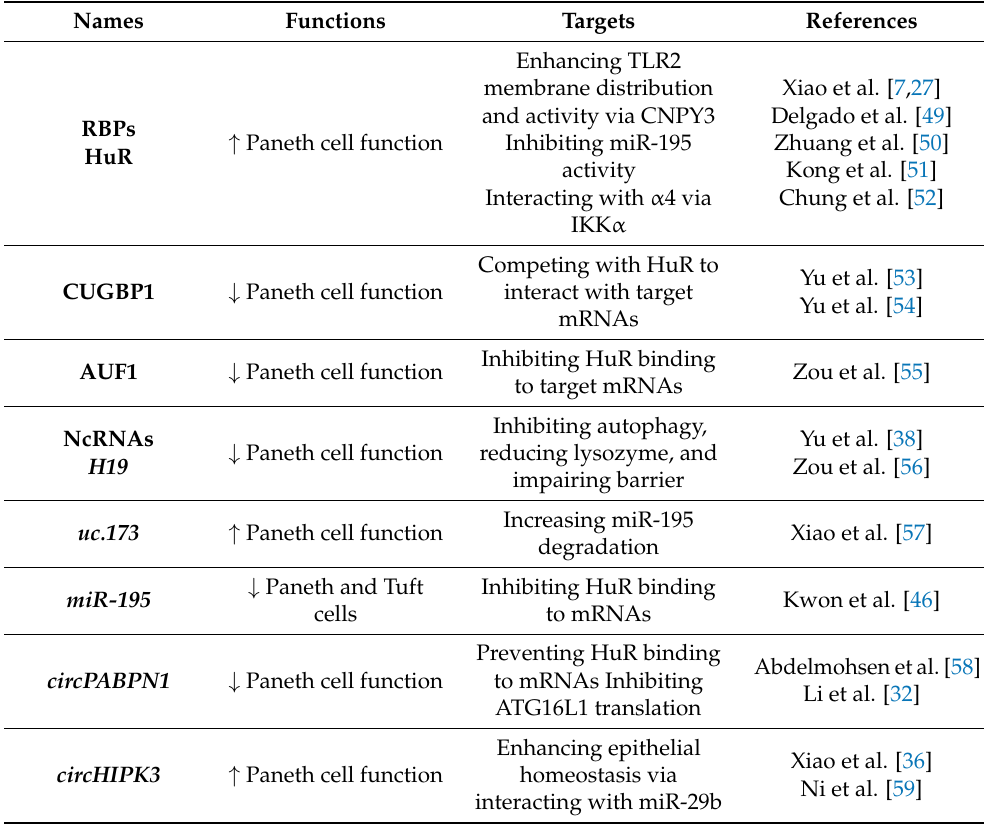
Table 2. Roles of RBPs and ncRNAs in the regulation of Paneth cell